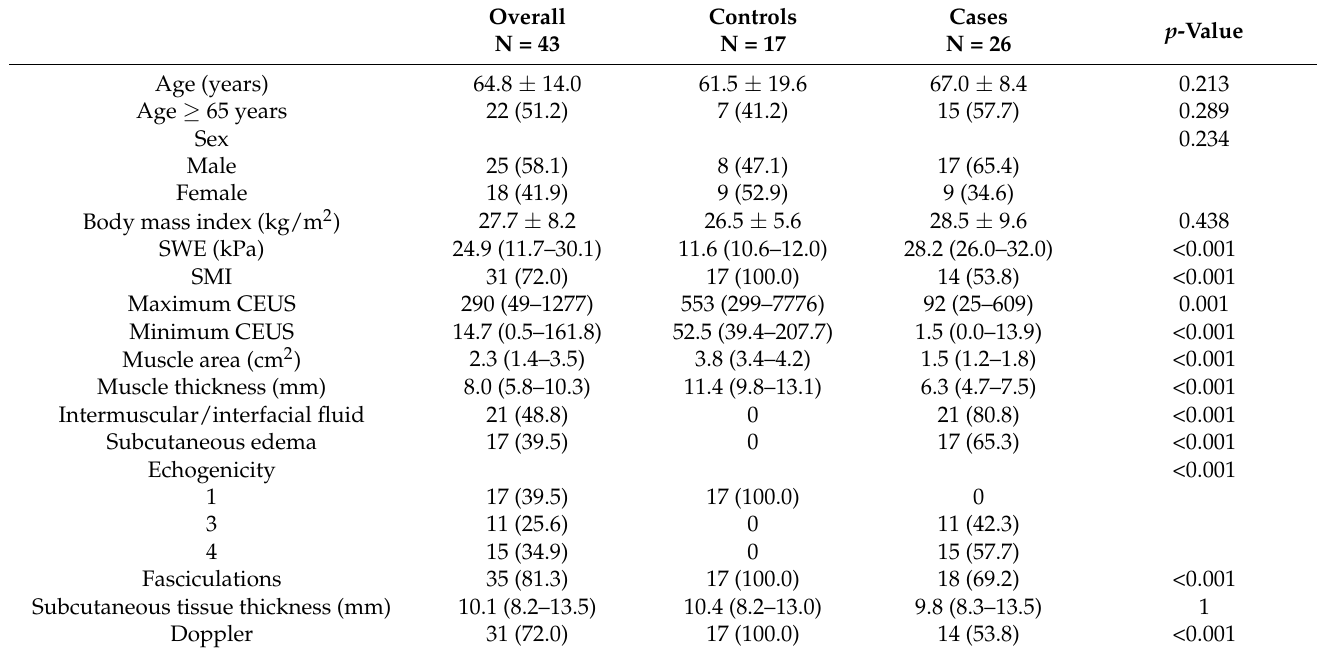
Table 1. Characteristics of the cases and